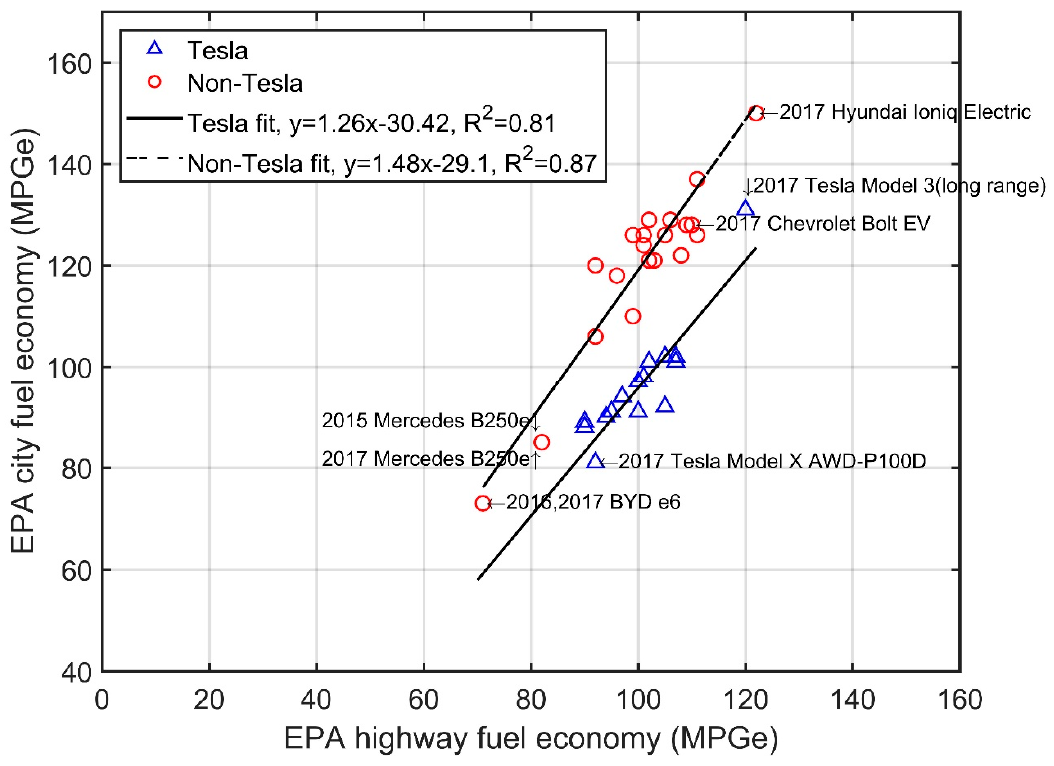
Figure 5. Correlation between EPA city mileage and EPA highway mileage for light duty BEVs.